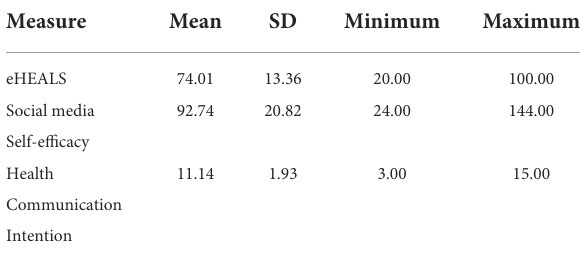
TABLE 2 Participants’ scores for the eHEALS, social media self-efficacy, and health communication intention ( N =